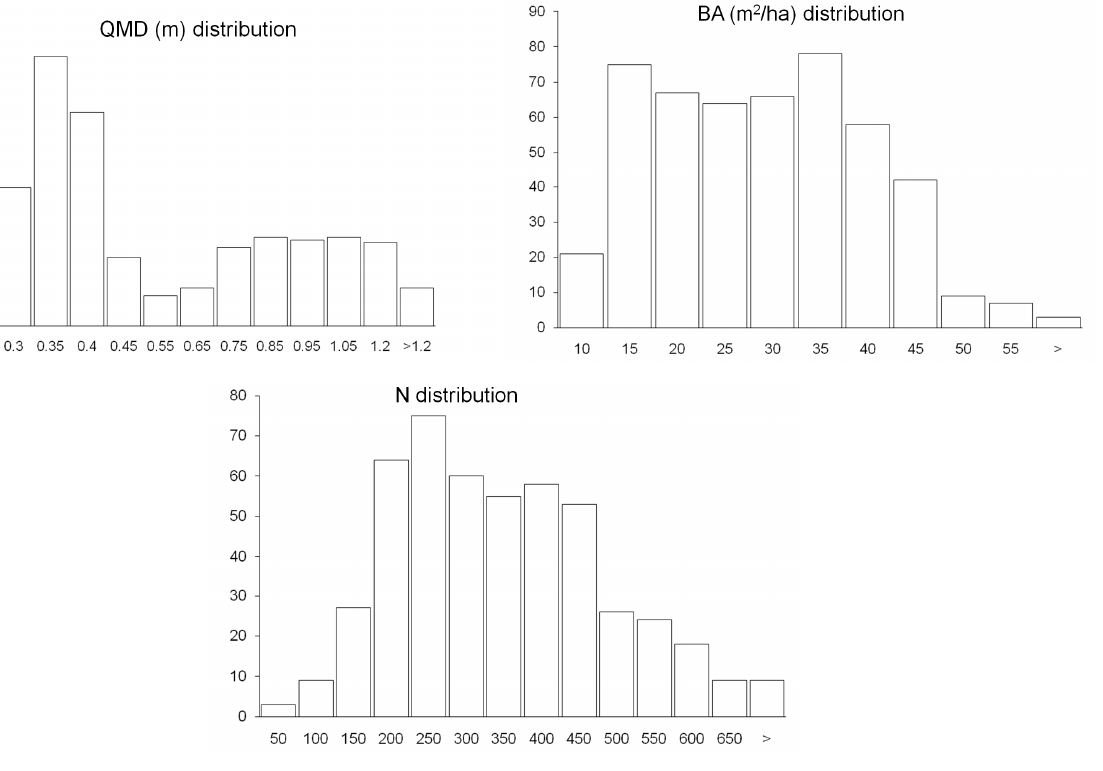
Figure 3. Distribution of the structural parameters (QMD, BA, N) in the stand-like polygons produced with the segmentation of the satellite images. Note that QMD graph bins are not all equal.